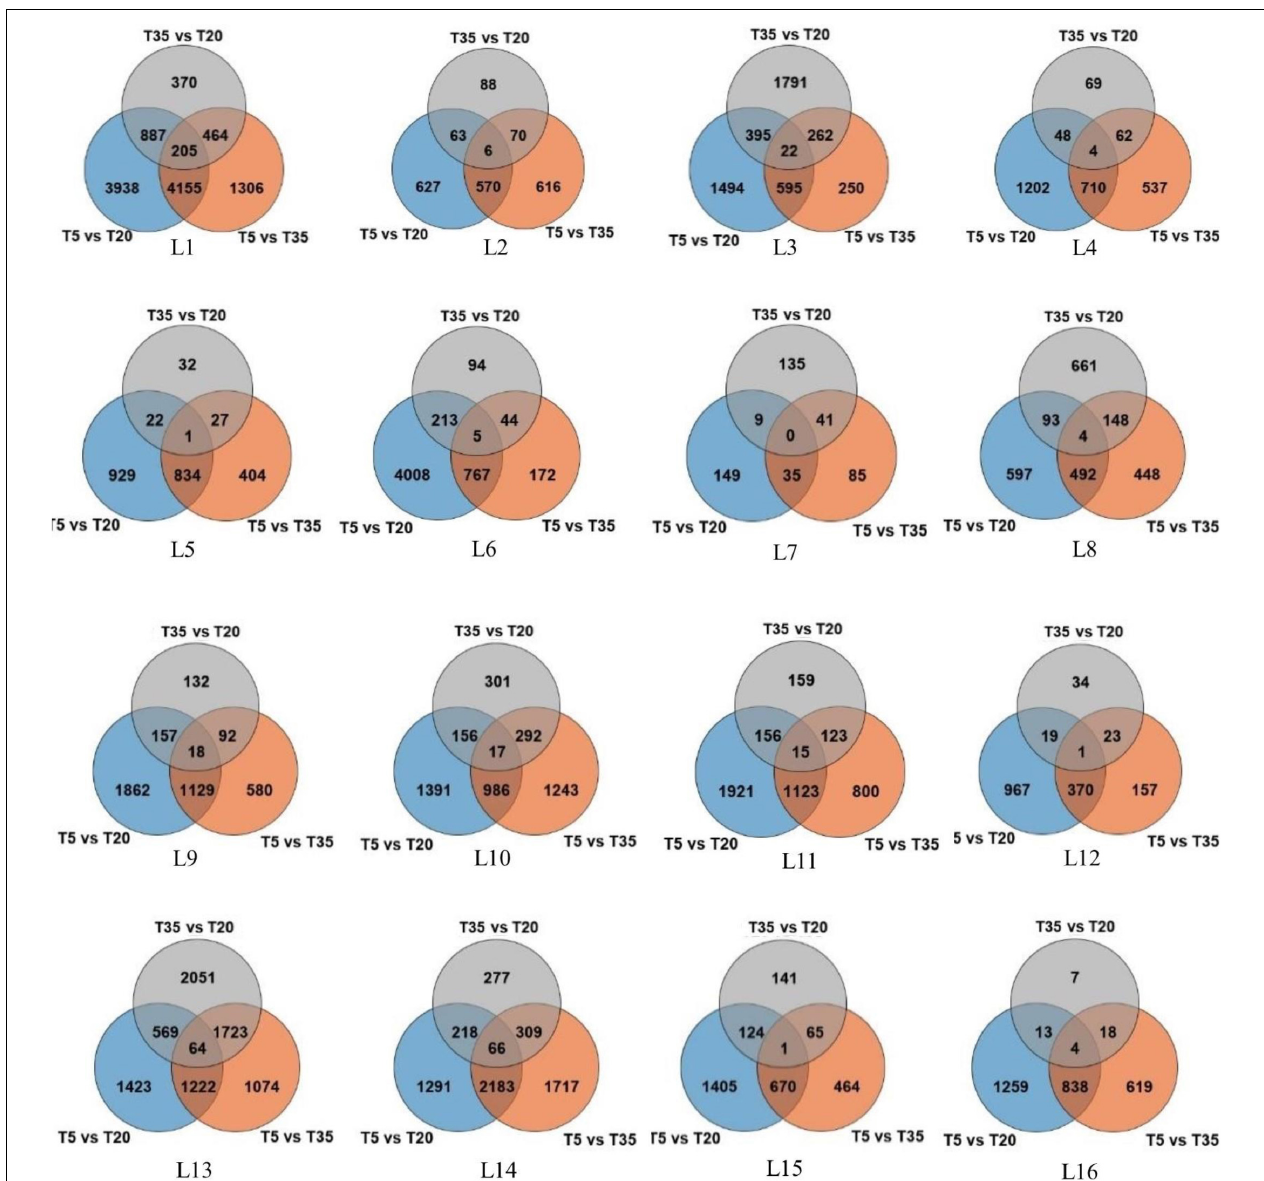
FIGURE 1 | Venn diagram representation of the number of differentially expressed genes (DEGs) identified by RNA-seq analysis in the leaves of bermudagrass from 16 different latitudes across three temperature